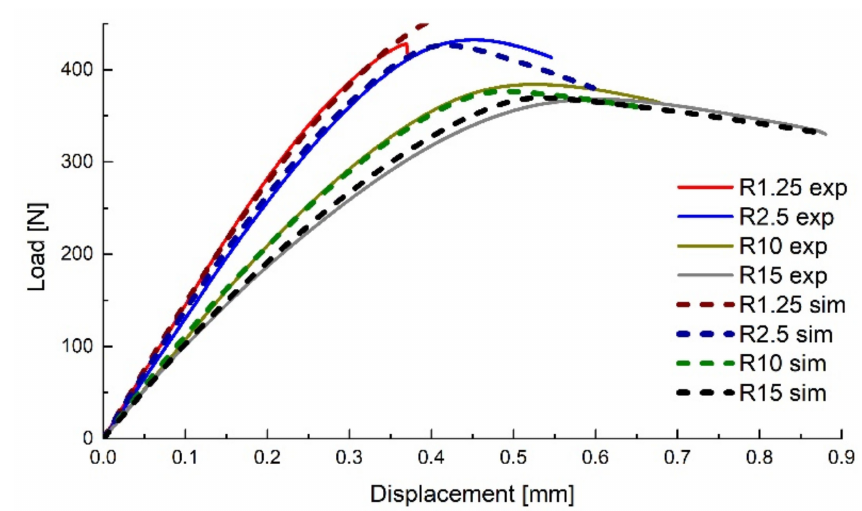
Figure 3. Comparison between the experimental and numerical force–displacement curves for the flat specimens.